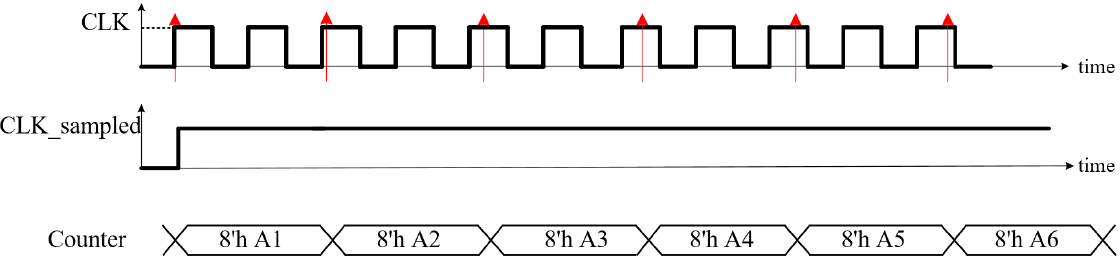
Figure 2. Timing diagram of asynchronous sampling when N = 2 and α << 1 (the frequency of CLK is very close to the second harmonic of CLK_async).